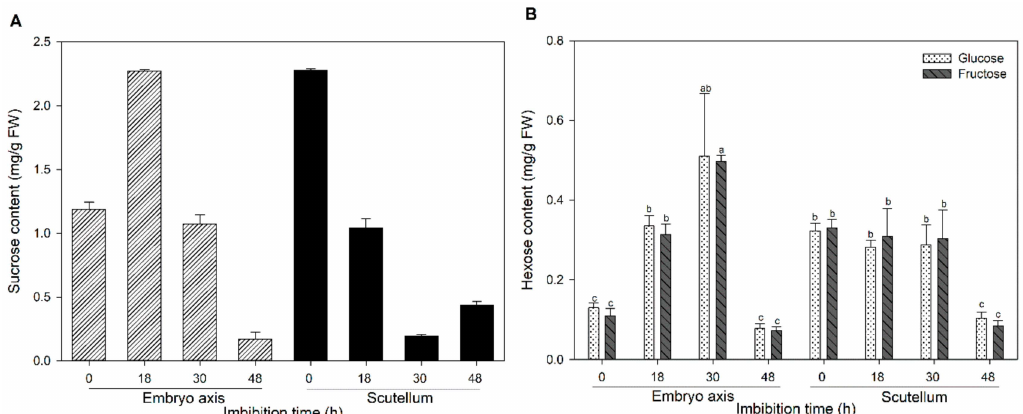
Figure 4. Sucrose ( A ) and hexose ( B ) content in tissues at di ff erent imbibition times. Bars show the content of soluble sugars from two independent experiments with triplicates ± SD. Di ff erent letters indicate statistically significant values according to the Tukey test, p < 0.05.